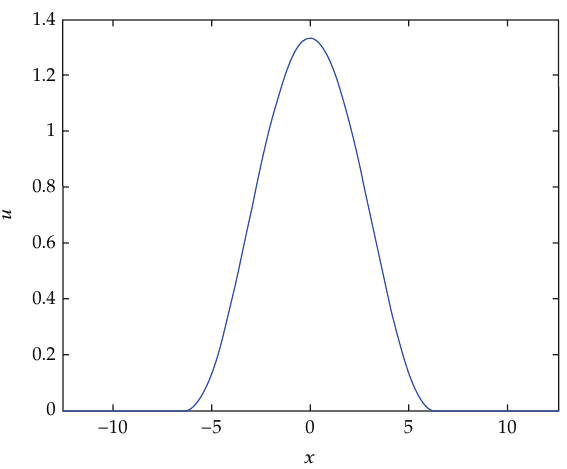
Figure 3: Compacton wave without